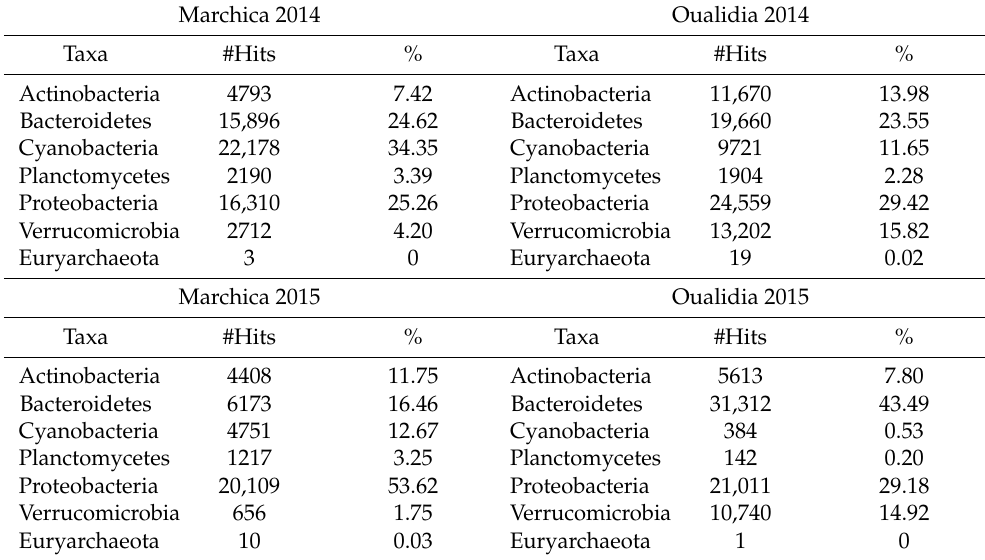
Table 4. 16s rRNA amplicon sequences from selected high abundant sequences assigned to a phylum for both sampling campaigns 2014 and 2015 in both